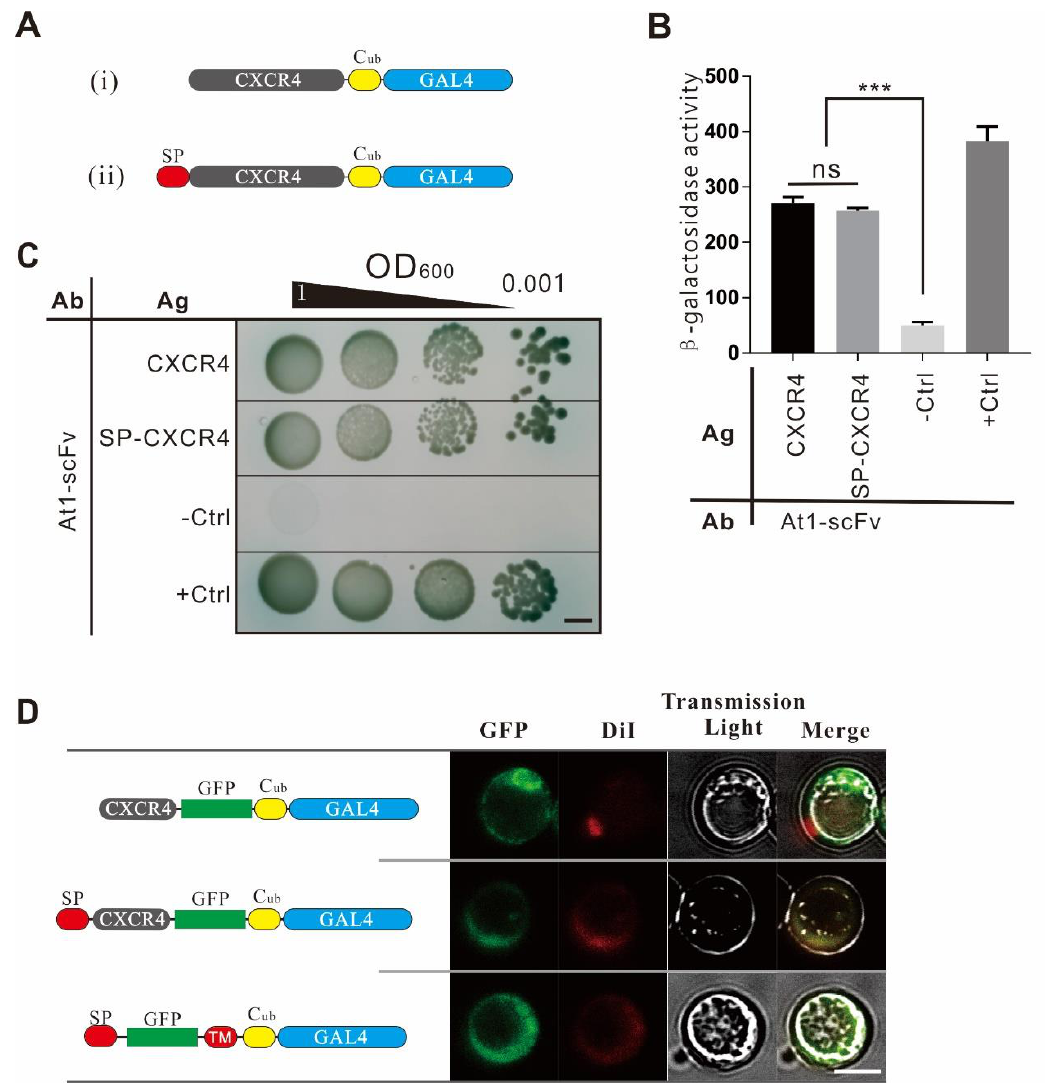
Figure 5. Optimization of antigen module localization by signal peptides. ( A ) Diagram of antigen structures w/o